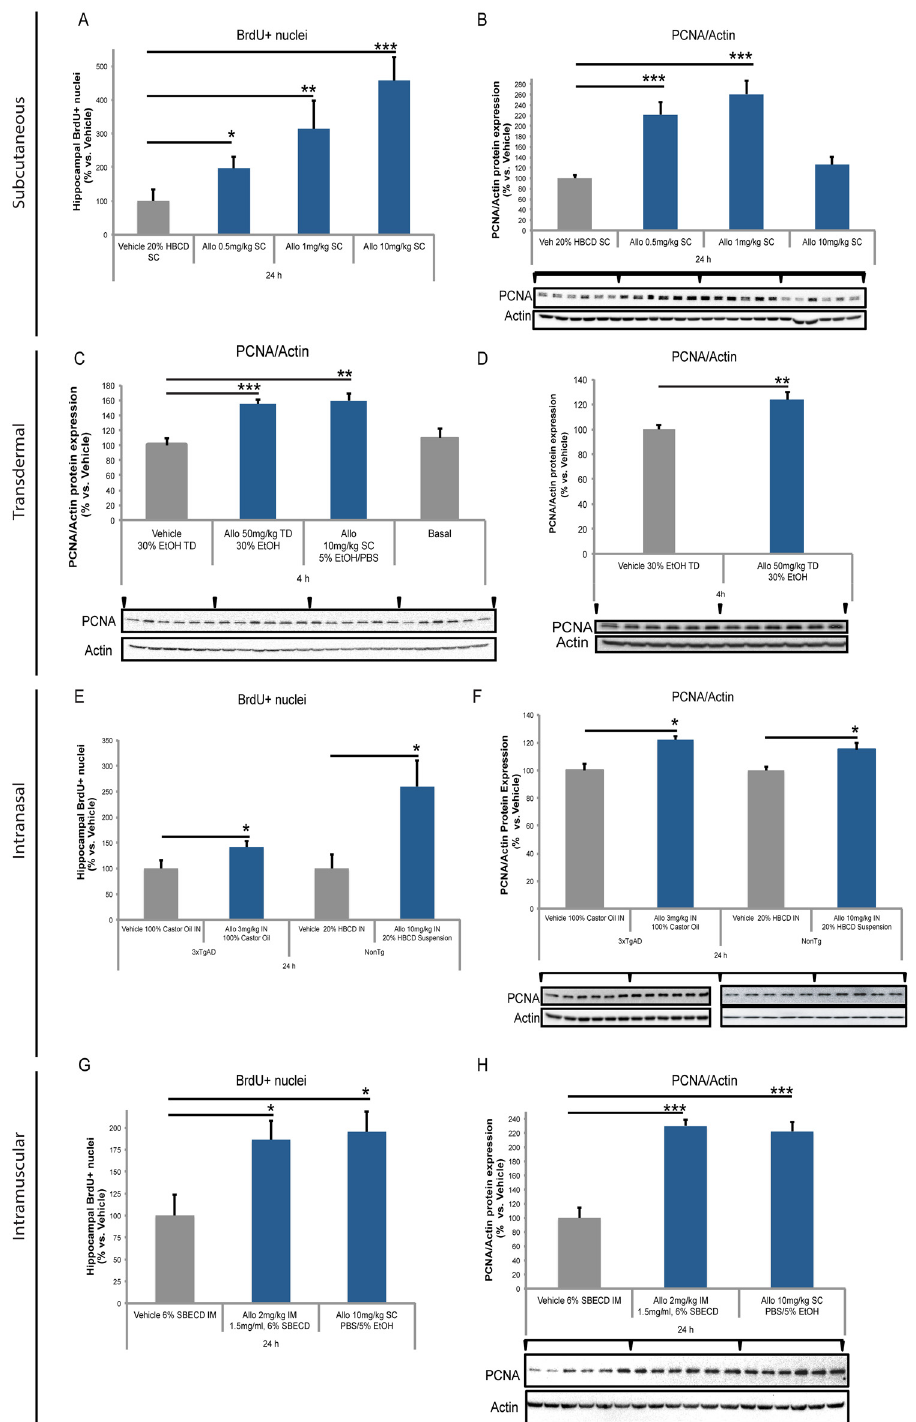
Fig 3. Subcutaneous Allo increased BrdU incorporation and PCNA protein expression in male mouse AD model. A. In 5-month-old 3xTgAD mouse hippocampus, BrdU+ nuclei increased significantly in 24 h after a single subcutaneous (SC) dose of Allo 0.5, 1, or 10 mg/kg. B. In 5-month-old 3xTgAD mouse hippocampus, protein expression of ~29 kDa PCNA increased significantly at 24 h after SC Allo 0.5 and 1 mg/kg doses whereas 10 mg/kg dose trended towards increase but did not reach significance. Transdermal and